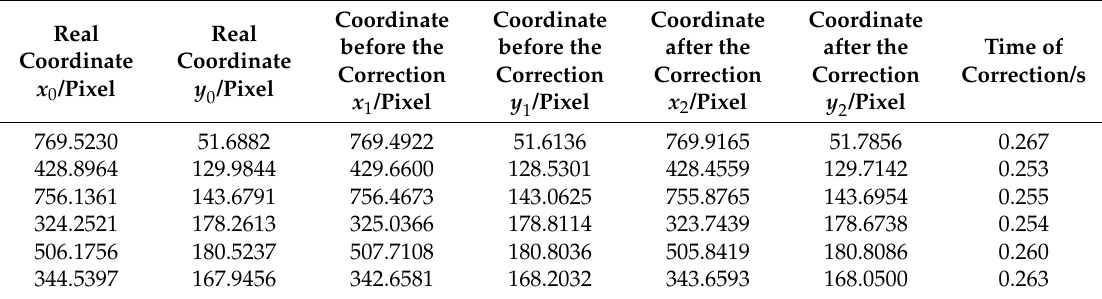
Table 2. The mean square error of errors table before and after the correction of simulation. Errors before the correction/pixel 0.0808 1.6426 1.8992 Errors after the correction/pixel